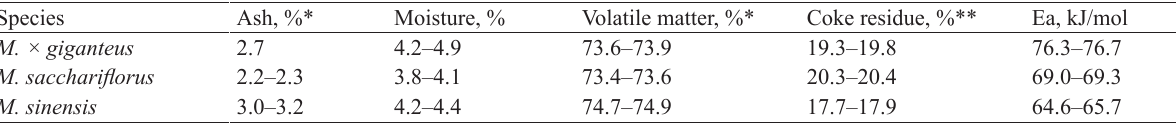
Table 4 Energy characteristic of the genus Miscanthus plants Species Ash, %* Moisture, % Volatile matter, %* Coke residue, %** Ea,